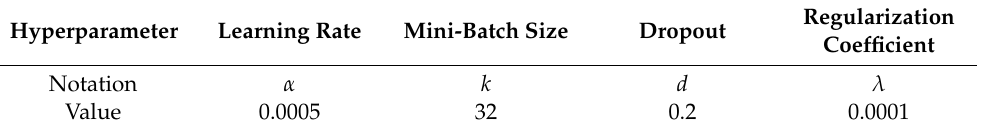
Table 3. Hyperparameters setting.